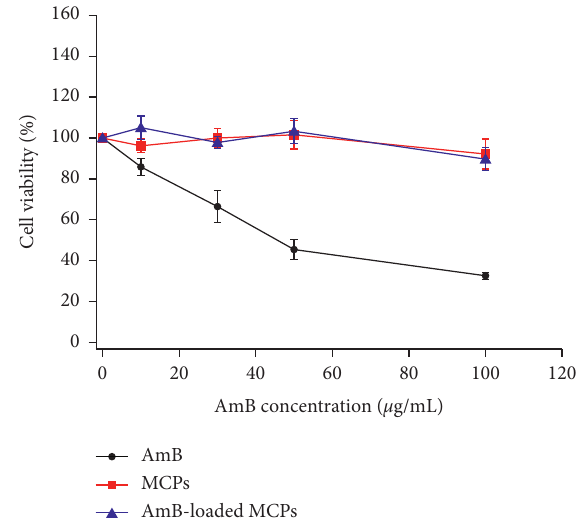
Figure 6: Cell viability of human lung cells treated with free AmB or AmB-loaded MCPs for 48 hours. The amount of AmB-loaded MCPs added corresponded to an equivalent amount of free AmB. MCPs represent blank microparticles at the concentration used for AmB-loaded MCPs. Error bars represent the standard error of four independent